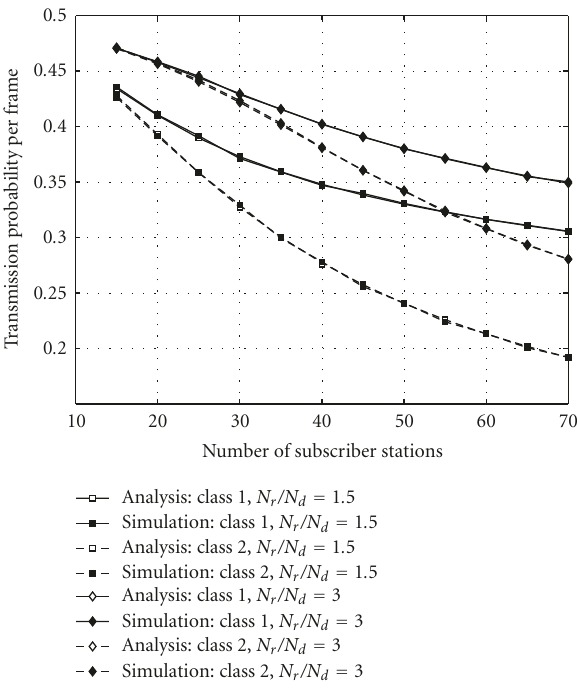
Figure 2: Delay of SS versus the number of SSs with equal bandwidth allocation priority and di ff erentiated channel access parameters: W 0,1 = W 0,2 = N r , W x ,1 = 2 4 W 0,1 and W x ,2 = 2 8 W 0,2 .